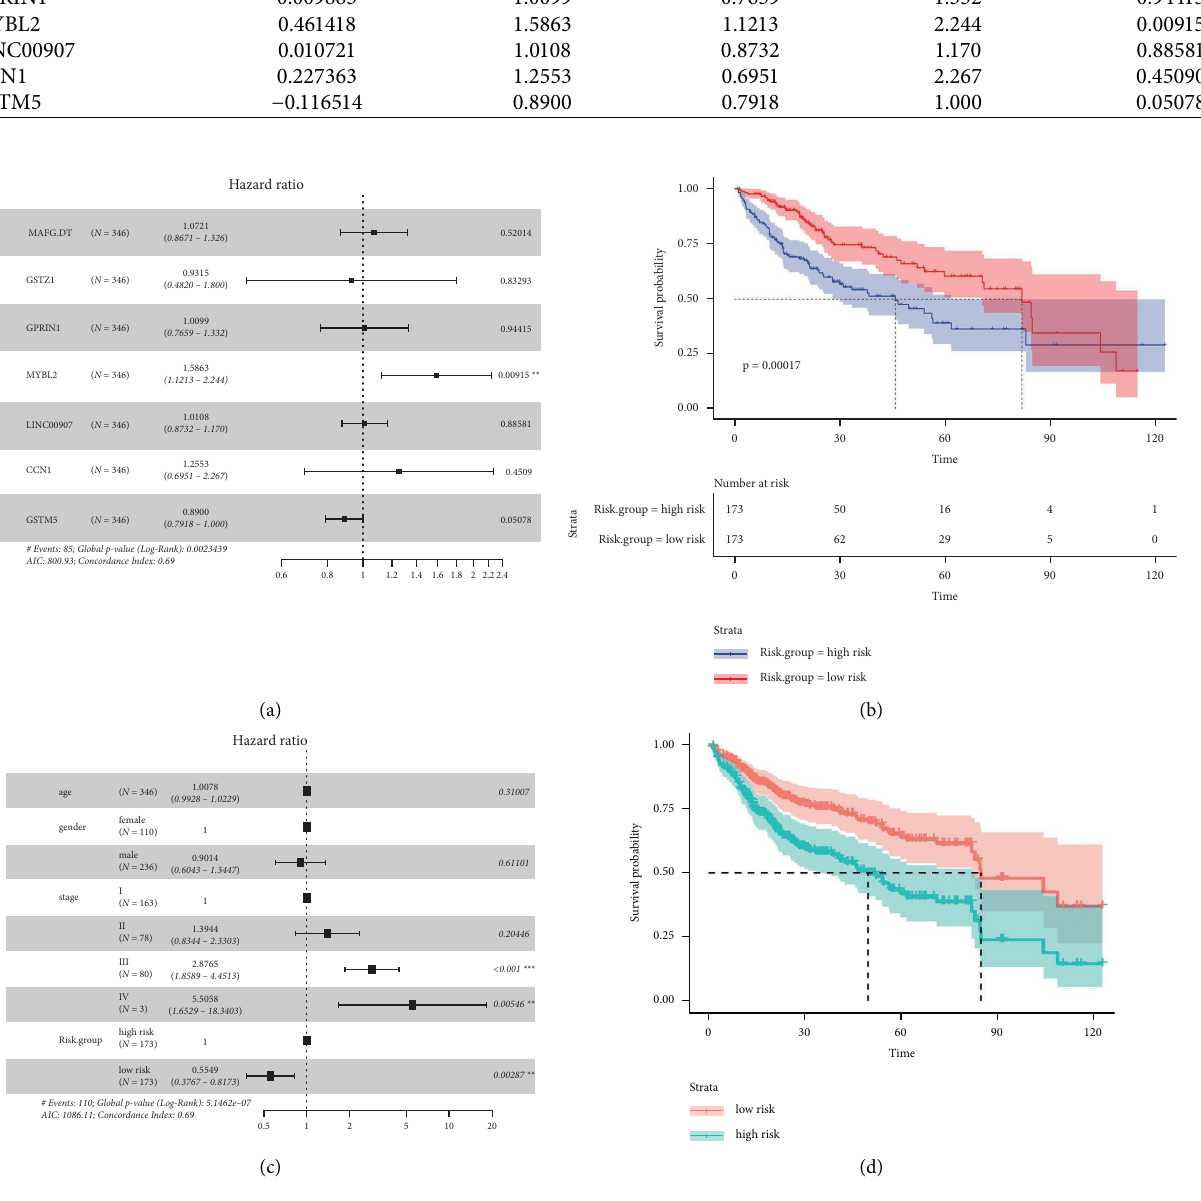
Figure 8: Prognostic analysis of HCC patients: (a) multivariate Cox analysis of important DEGs for the prognosis of HCC patients; (b) survival analysis of high-risk and low-risk groups; (c) multivariate Cox analysis of the prognosis of HCC patients with diferent clinical status; (d) Cox proportional-hazards model ( ∗ P < 0 . 05, ∗∗ P < 0 . 01, ∗∗∗ P < 0 .